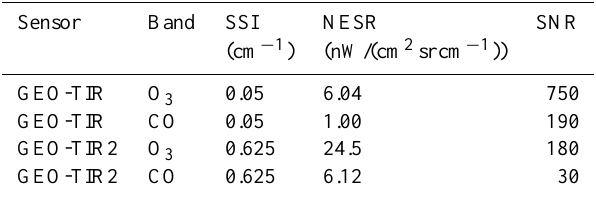
Table 1. GEO-TIR and GEO-TIR2 instrument characteristics in the O 3 and CO thermal infrared band: Spectral Sampling Interval (SSI), Noise Equivalent Spectral Radiance (NESR) and Signal to Noise Ratio (SNR) calculated for a surface temperature of